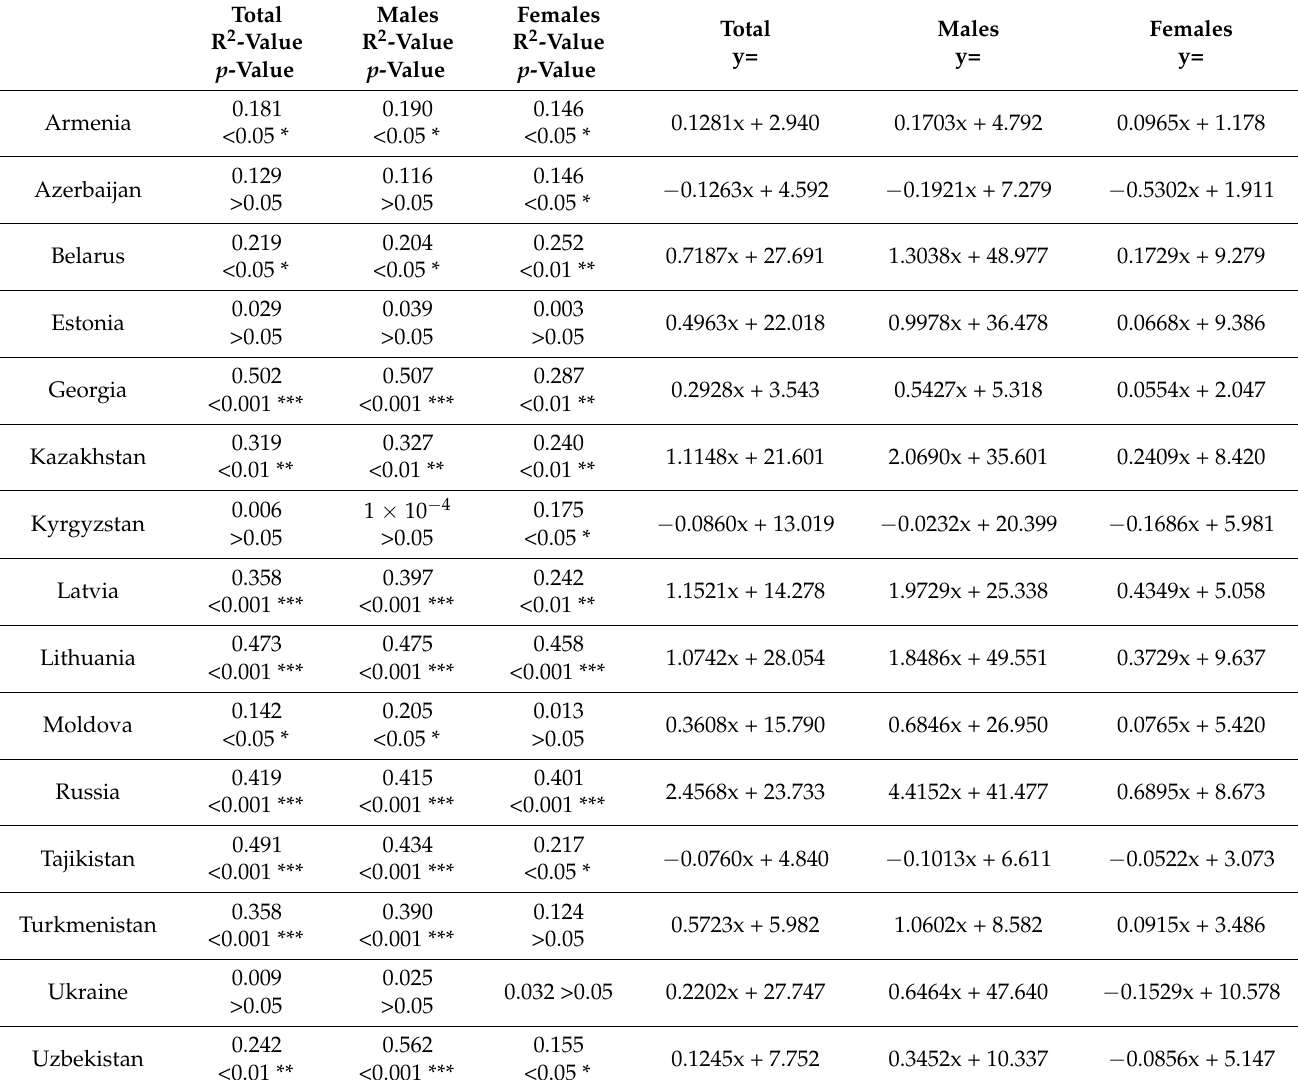
Table 2. The association between the suicide rate and the unemployment rate, and the regression lines in the simple regression